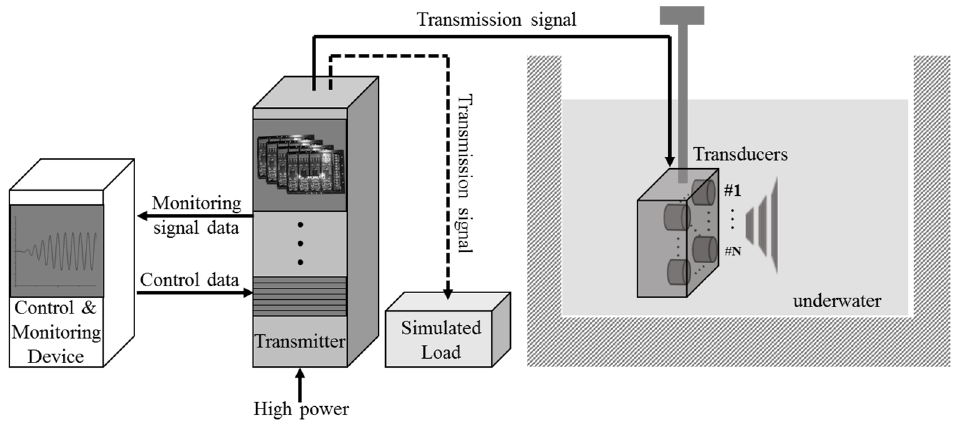
Figure 8. The experimental setup diagram of the transmitter control, using the simulated load and the MCAT load.